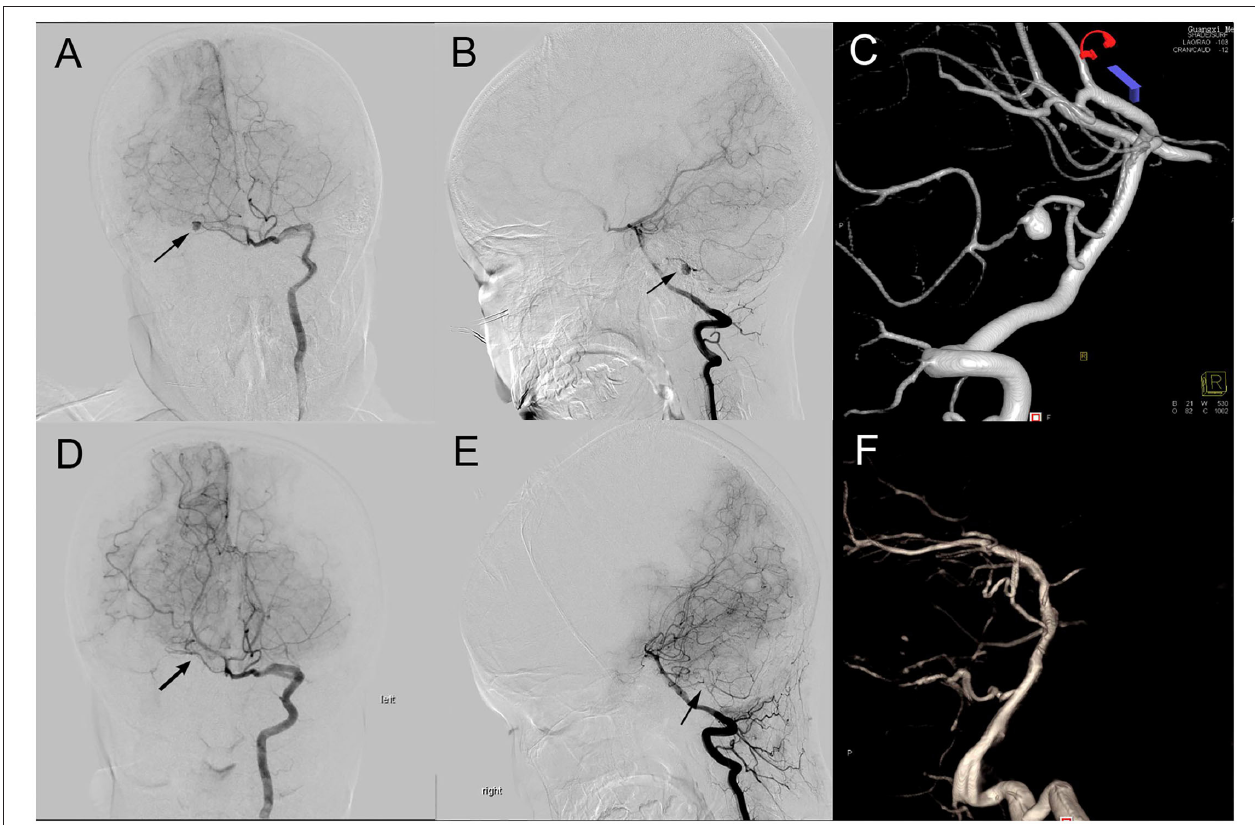
FIGURE 1 | Preoperative and postoperative DSA comparison. (A–C) : Preoperative DSA (A, A-P view; B, lateral view) showing an aneurysm (black arrow) located at main trunk of the right AICA; (D–F) : Preoperative DSA (D, A-P view; E, lateral view) showing the aneurysm disappeared and the distal AICA patency.